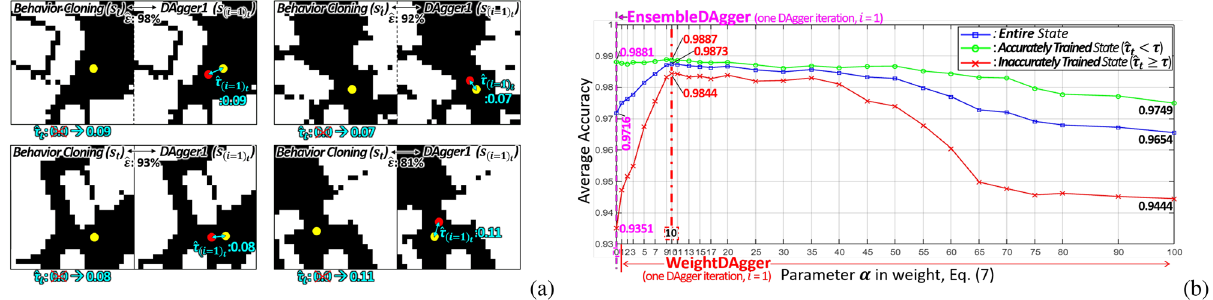
Figure 15. ( a ) Weight update processes ( Step 2 ) with ε = 70% when DAgger (e.g. EnsembleDAgger in this figure) is executed at once ( i = 1). ( b ) Results of the average accuracy according to parameter α ; α of 0 is the same case as EnsembleDAgger